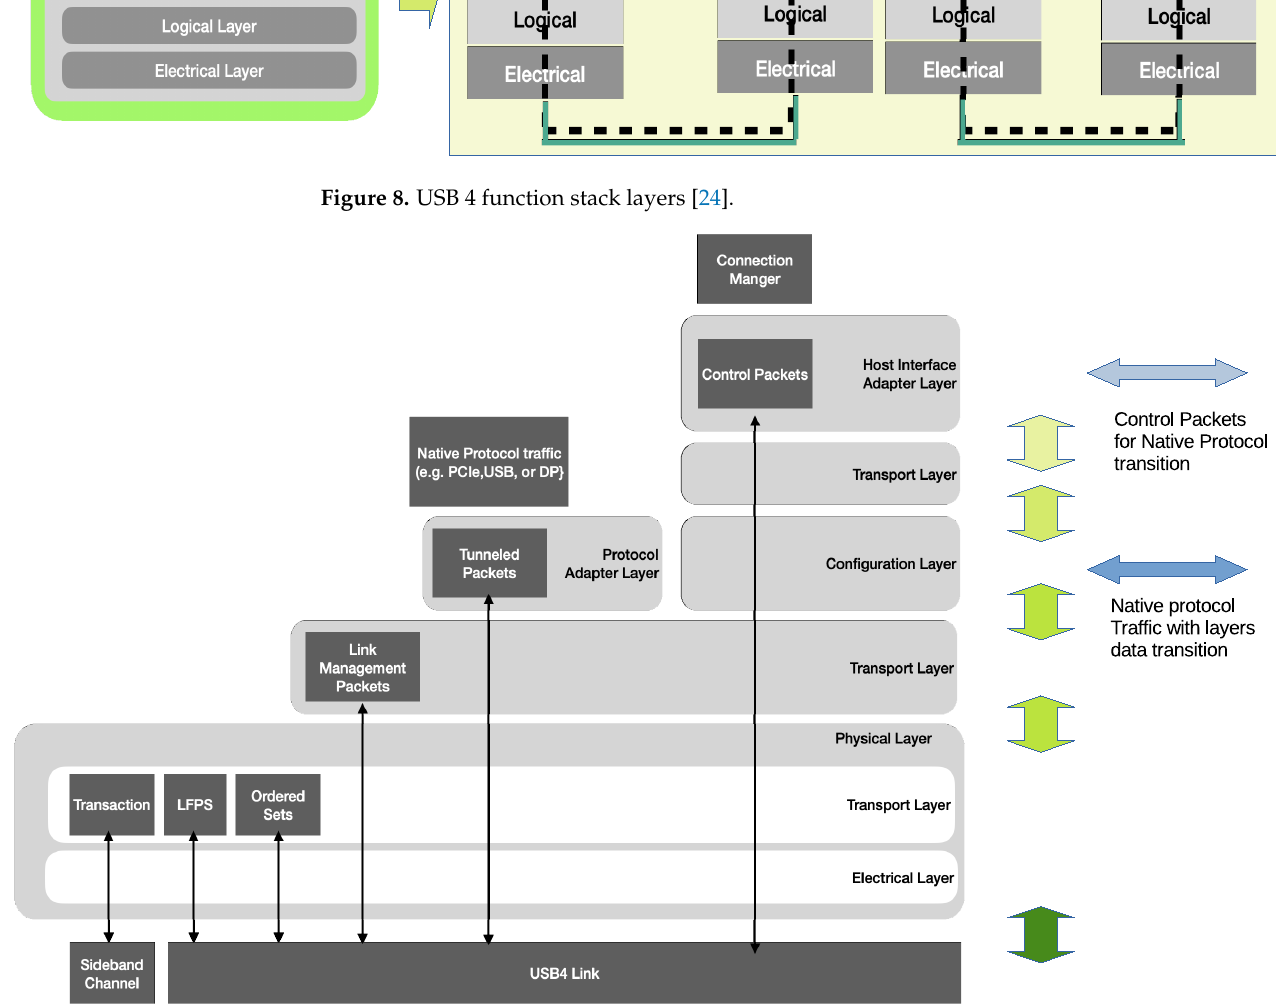
Figure 9. USB 4 communication by function layer